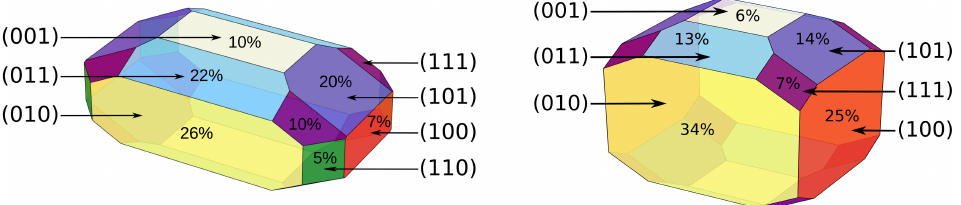
Figure 4. Wulff Plots of YF 3 (left, PBE) and HoF 3 (right, PBE+U d /3 eV/4f-in-core) from relaxed surfaces. The percentage shows the relative abundance of each surface, which is also given in Table